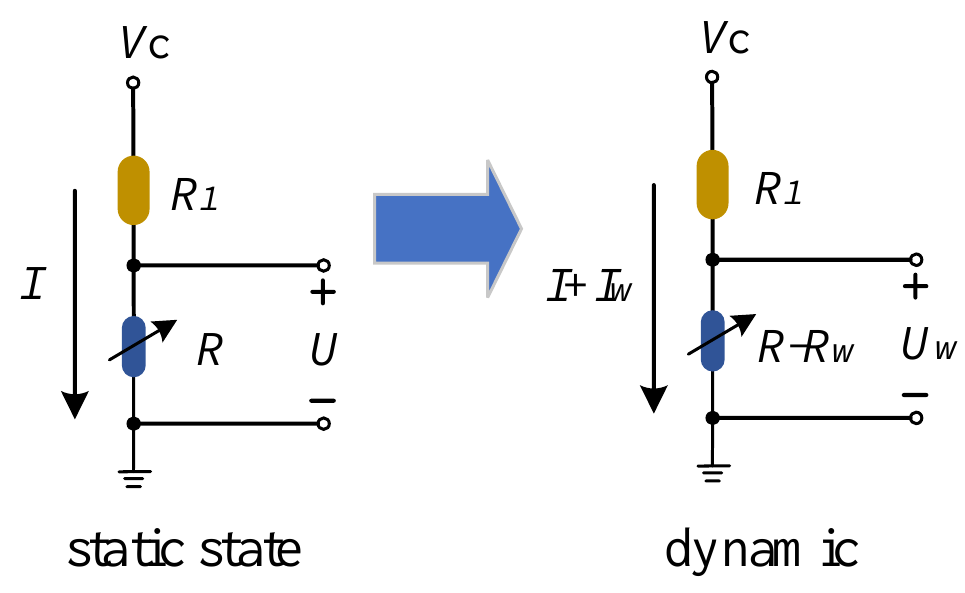
Figure 2. Constant voltage heating. When the fluid is stationary, the equilibrium formula can be expressed as Formula (1). The relationship between the resistance value R of the platinum resistance and the tempera- ture T can be expressed as Formula (2).